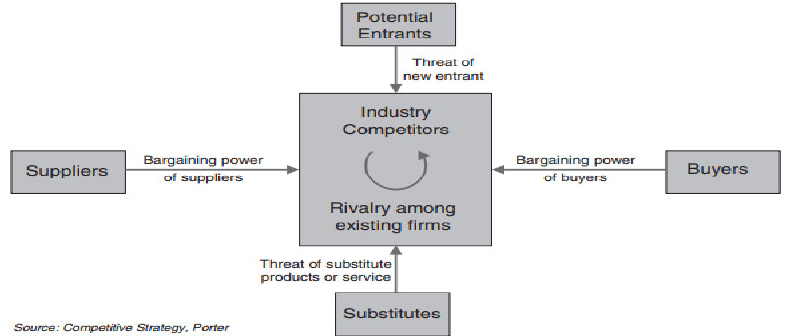
Figure 2. These forces determine industrial profitability (Grundy 2006).